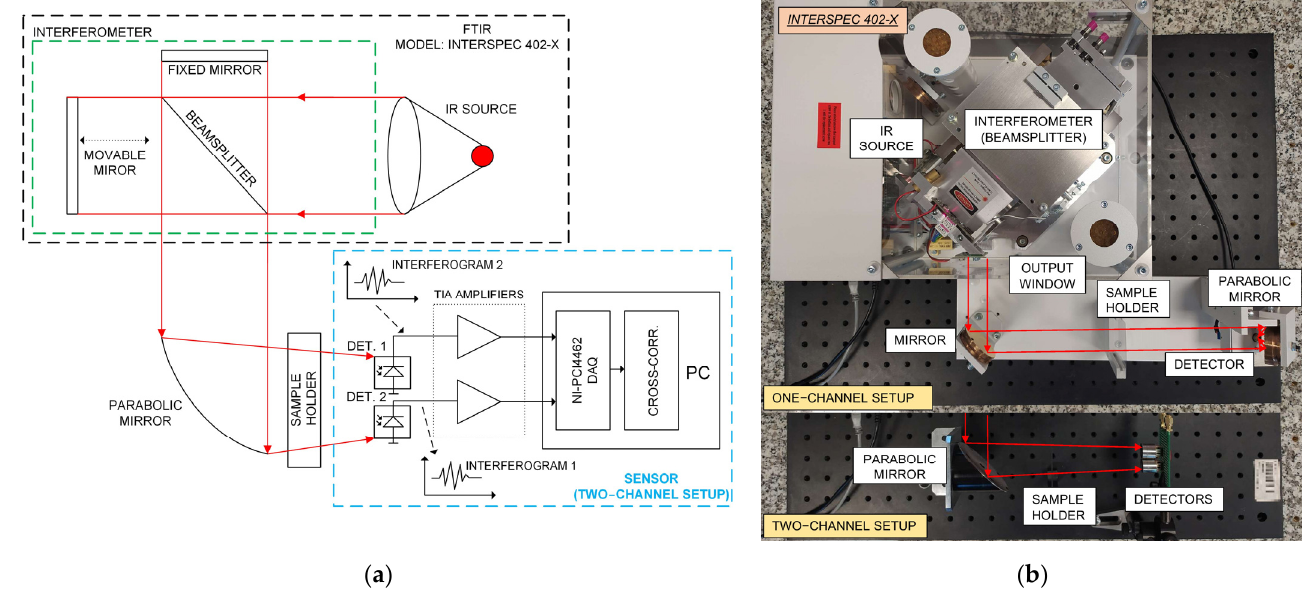
Figure 2. Scheme ( a ) and photo ( b ) of an FTIR spectrometer with a designed